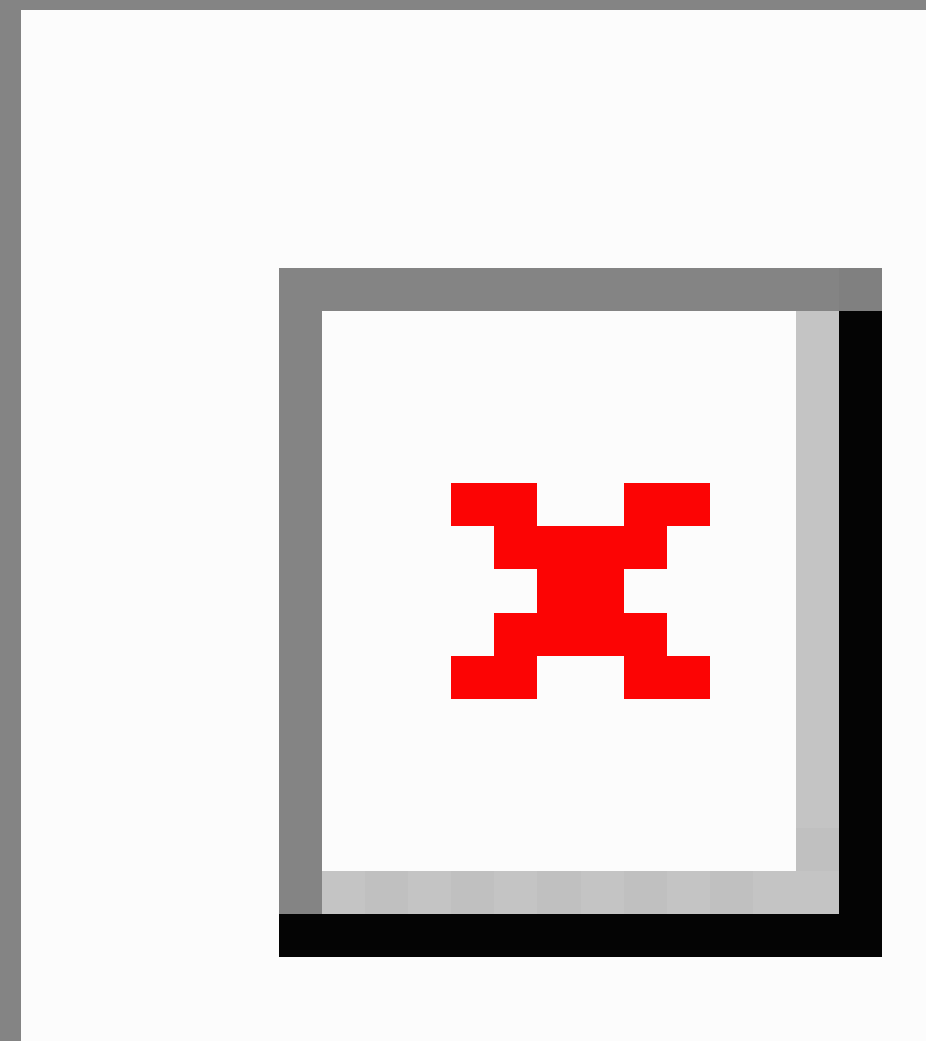
Figure 4. Comparison of Study 1 & 2